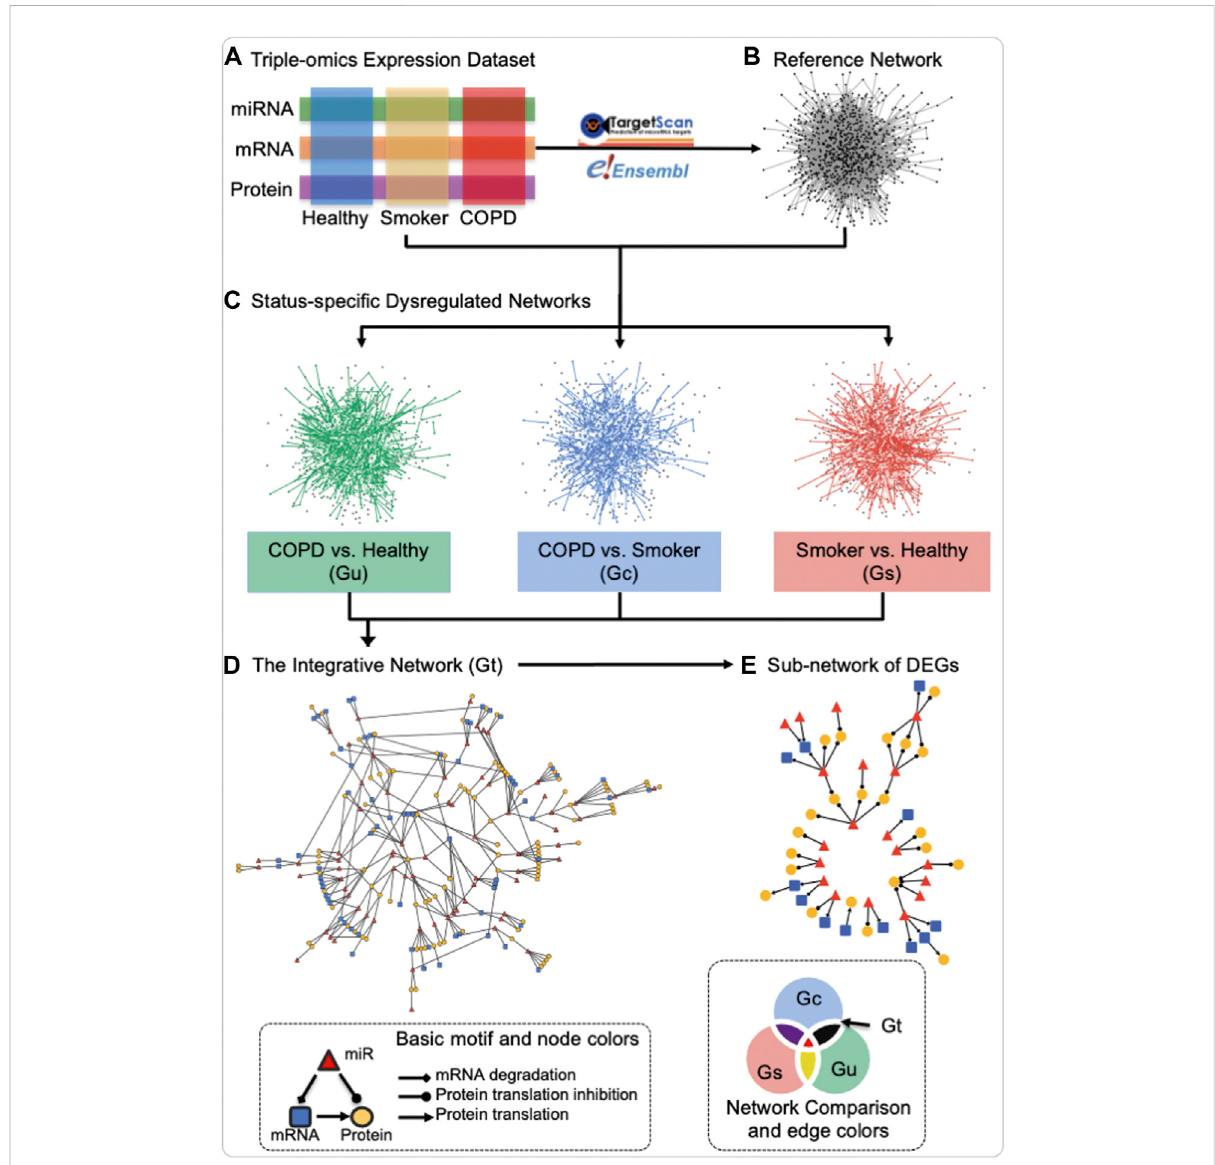
FIGURE 1 Schematic of the construction of the miRNA – mRNA – protein dysregulation network. Three data modalities (miRNA, mRNA, and protein) from the three groups of healthy never-smokers (healthy), current-smokers with mild-to-moderate COPD (COPD), and smokers with normal lung function (smokers) (A) were utilized for the construction of a reference network by mapping miRNA to mRNA regulation and mRNA to protein translation in TargetScan and Ensembl databases (B) , resulting in the union of three-node basic motifs (bottom left inset). Status-speci fi c dysregulated networks from each contrast of interest were then extracted from differentially co-expressed interactions in each status comparison (C) Anintegrativedysregulatednetwork (D) wasthenconstructedusingthenetwork setoperationillustratedin “ NetworkComparison ” (bottomright inset), where Gt (black) represents the main contrast of interest for this investigation, namely, the difference between the “ status-speci fi c dysregulated networks ” in “ COPD vs. healthy ” (Gu) and “ smoker vs. healthy ” (Gs), when intersected with the network of “ COPD vs. smokers ” (Gc). Finally, sub-networks containing differentially expressed genes (DEGs) were extracted for further investigation (E) In “ Basic motif and node colors, ” thenodeandedgeshapesappliedtoallpanelsandthenodecolorsusedthatofpaneldand (E) In “ NetworkComparisonandedgecolors, ” thecolors fordifferentnetworkscorrespondedtobothedgeandnodeinpanel (C) TheedgeandnodecolorsaregreyandblackinReferenceNetworkofpanel (B) Created using igraph in R and